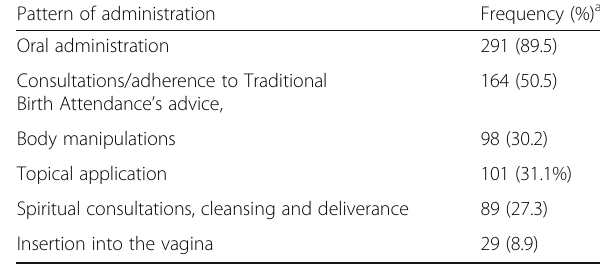
Table 5 Pattern of administration or consumption of